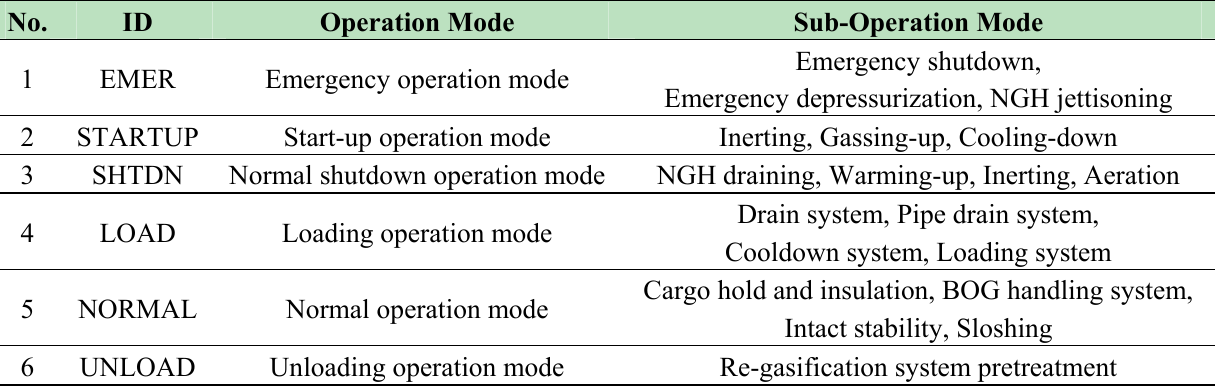
Table 3. Operation and sub-operation modes in NGH